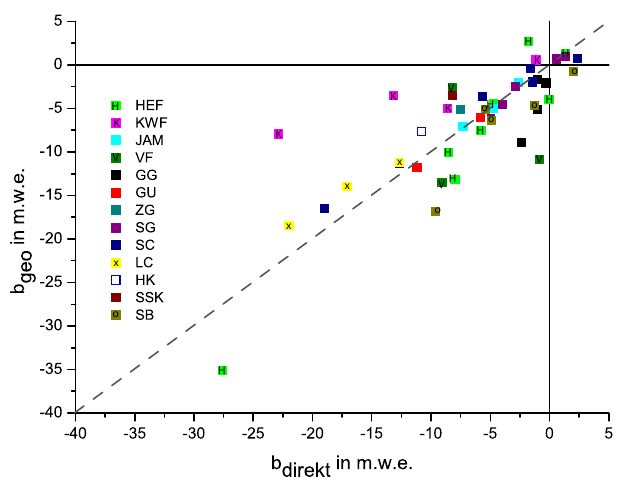
Fig. 18. Comparison of the geodetic b geo and direct b direct